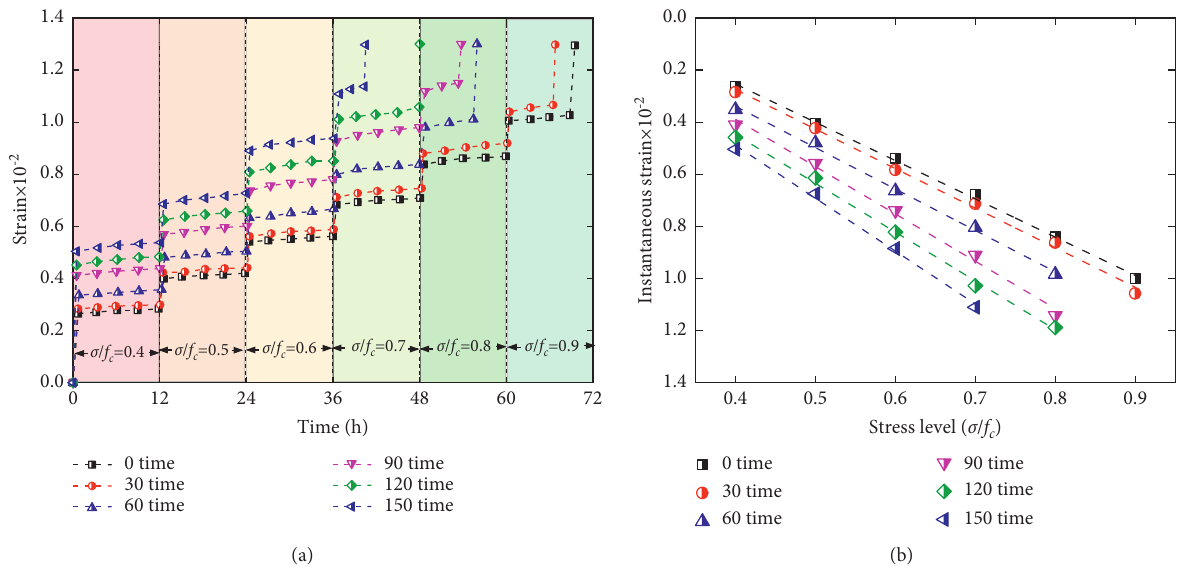
Figure 7: Relationship between stress level (a) and instantaneous strain (b) of CRC after cyclic freeze-thaw. (a) CRC-graded compression creep curve after freeze-thaw cycles. (b) Relationship between stress level and instantaneous strain of RC after a freeze-thaw cycle. Table 3: Fitting parameters under different freeze-thaw cycles. Fitting